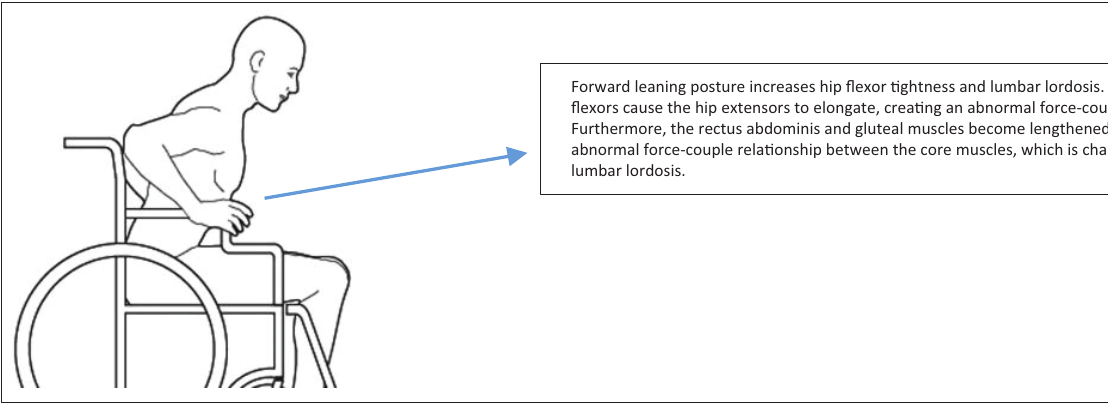
FIGURE 3: Sagittal plane analysis identifying poor